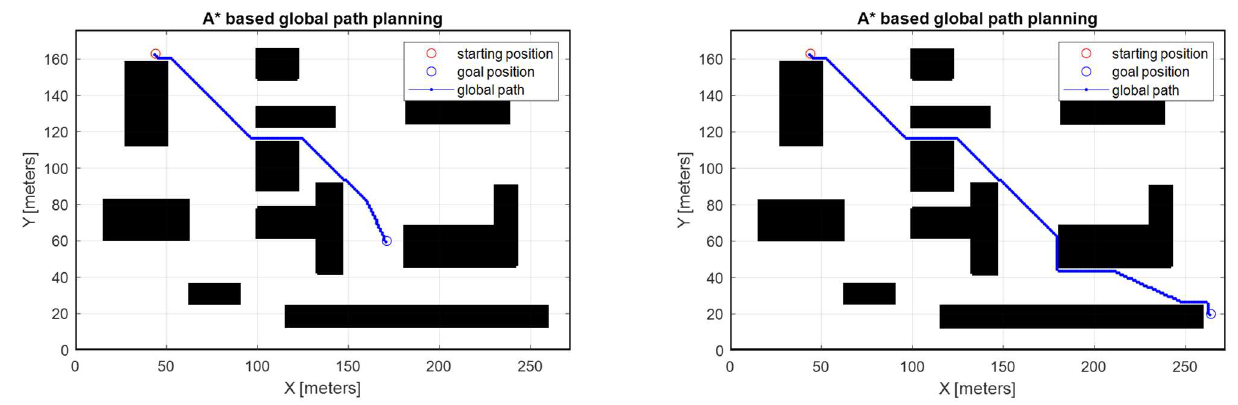
Figure 2. A-STAR-based global path planning.